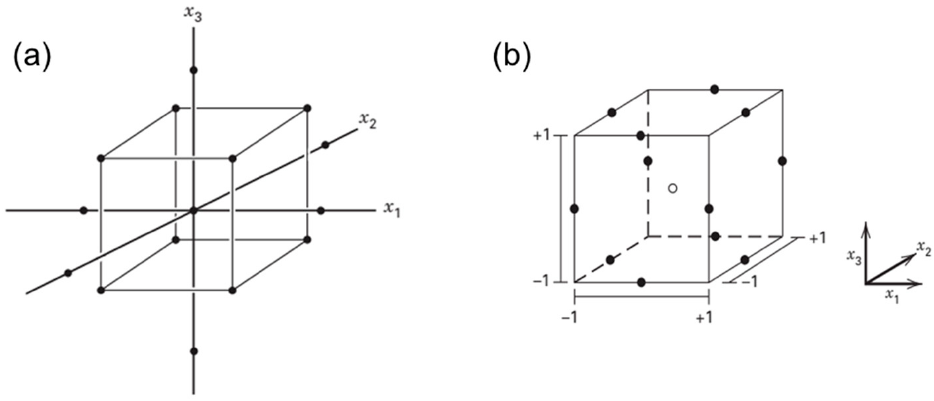
Figure 2. The central composite design ( a ) and Box-Behnken design ( b ) of three factors ( k = 3). Adapted from Montgomery [59].